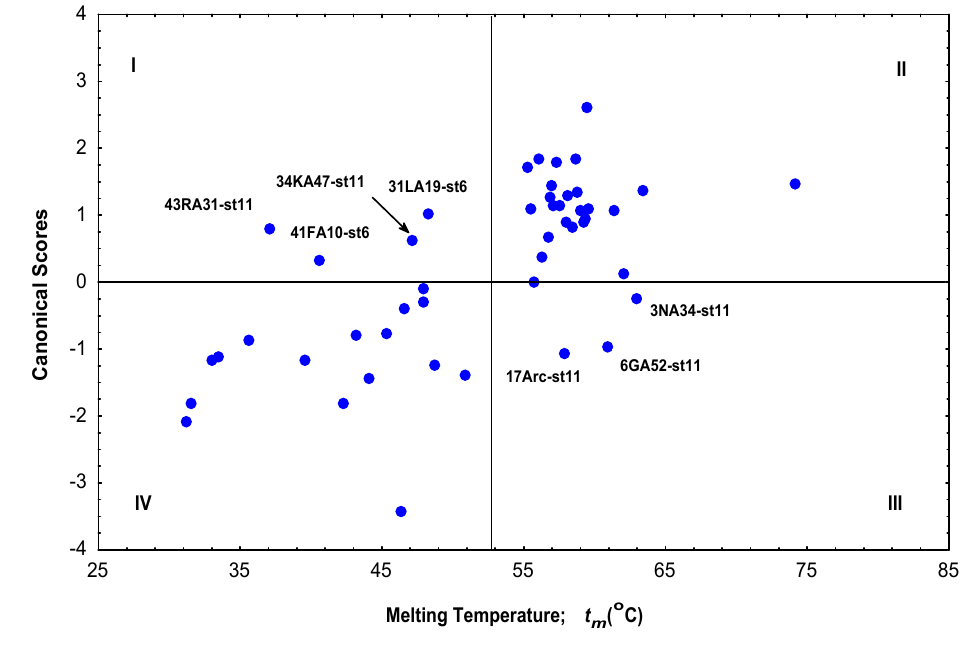
Figure 2. Overall ascendant tendency of canonical scores plotted in the same order in which t increases. Blocks I and III contain misclassified Arc